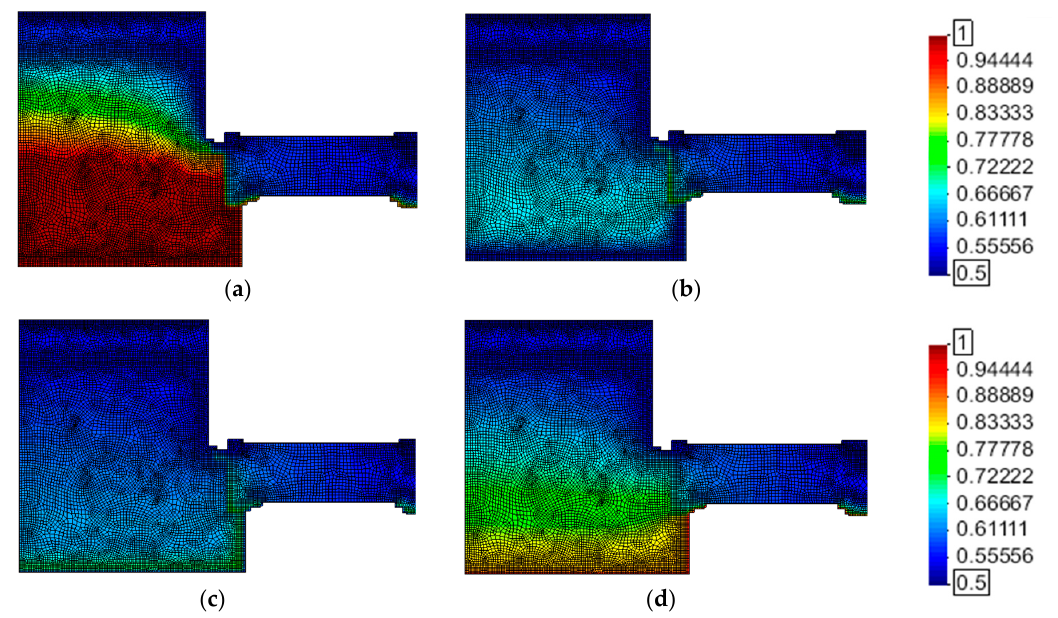
Figure 13. Relative humidity distribution (-) over the window jamb provided with the interior thermal insulation made of wood fibers: ( a ) 9 January, 16:00, ( b ) 10 April, 22:00, ( c ) 11 July, 11:00, and ( d ) 10 October, 10:00. The relative humidity values were obtained using computational modeling technique described in Section 4.